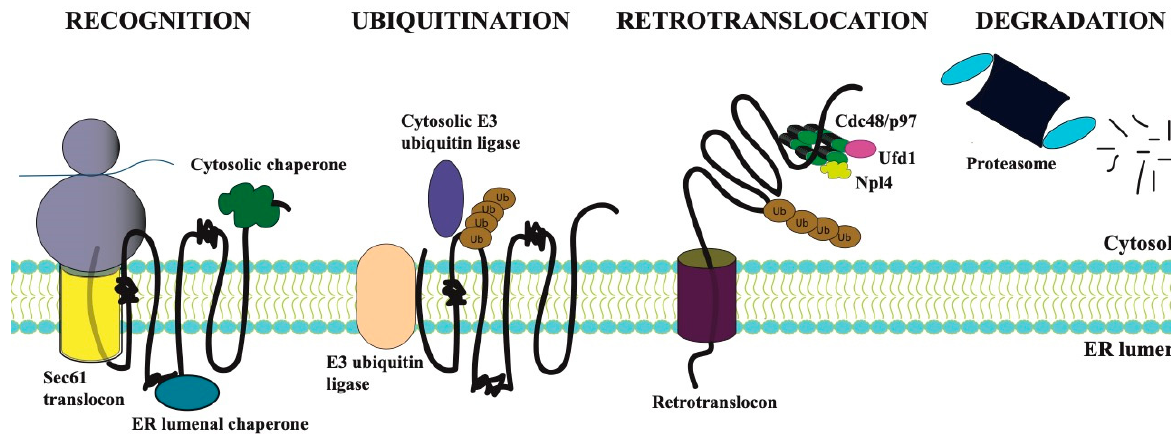
Figure 1. The endoplasmic reticulum-associated degradation (ERAD) pathway consists of four steps. The degradation pathway for a generic integral membrane protein in the ER is shown, and misfolded regions in the lumen, membrane, and cytosol are represented within the polypeptide chain as condensed regions. Recognition: Integral membrane proteins enter the ER concomitant with protein translation on ER-associated ribosomes and with the assistance of the Sec61 translocon. A misfold region in a nascent polypeptide is recognized by cytosolic or lumenal chaperones. Ubiquitination: The ubiquitination machinery—and more specifically an E3 ubiquitin ligases, often along with an E2 ubiquitin conjugating enzyme (not shown)—is next recruited to the misfolded protein, which is then conjugated with a polyubiquitin chain. The chain most commonly contains Lys-48 isopeptide linkages, and a minimum of four ubiquitins is required for proteasome-dependent degradation [14]. Retrotranslocation: The ubiquitinated protein is retrotranslocated through an ER-integrated retrotranslocon. Retrotranslocation requires ATP-dependent extraction mediated by the Cdc48 (in yeast) or p97 (in mammals) complex. The Cdc48/p97 complex also consists of two associated factors, Npl4 and Ufd1, which aid in ubiquitinated substrate capture. Degradation: During and/or after retrotranslocation, the misfolded ubiquitination substrate is degraded by the 26S proteasome into short peptide fragments.